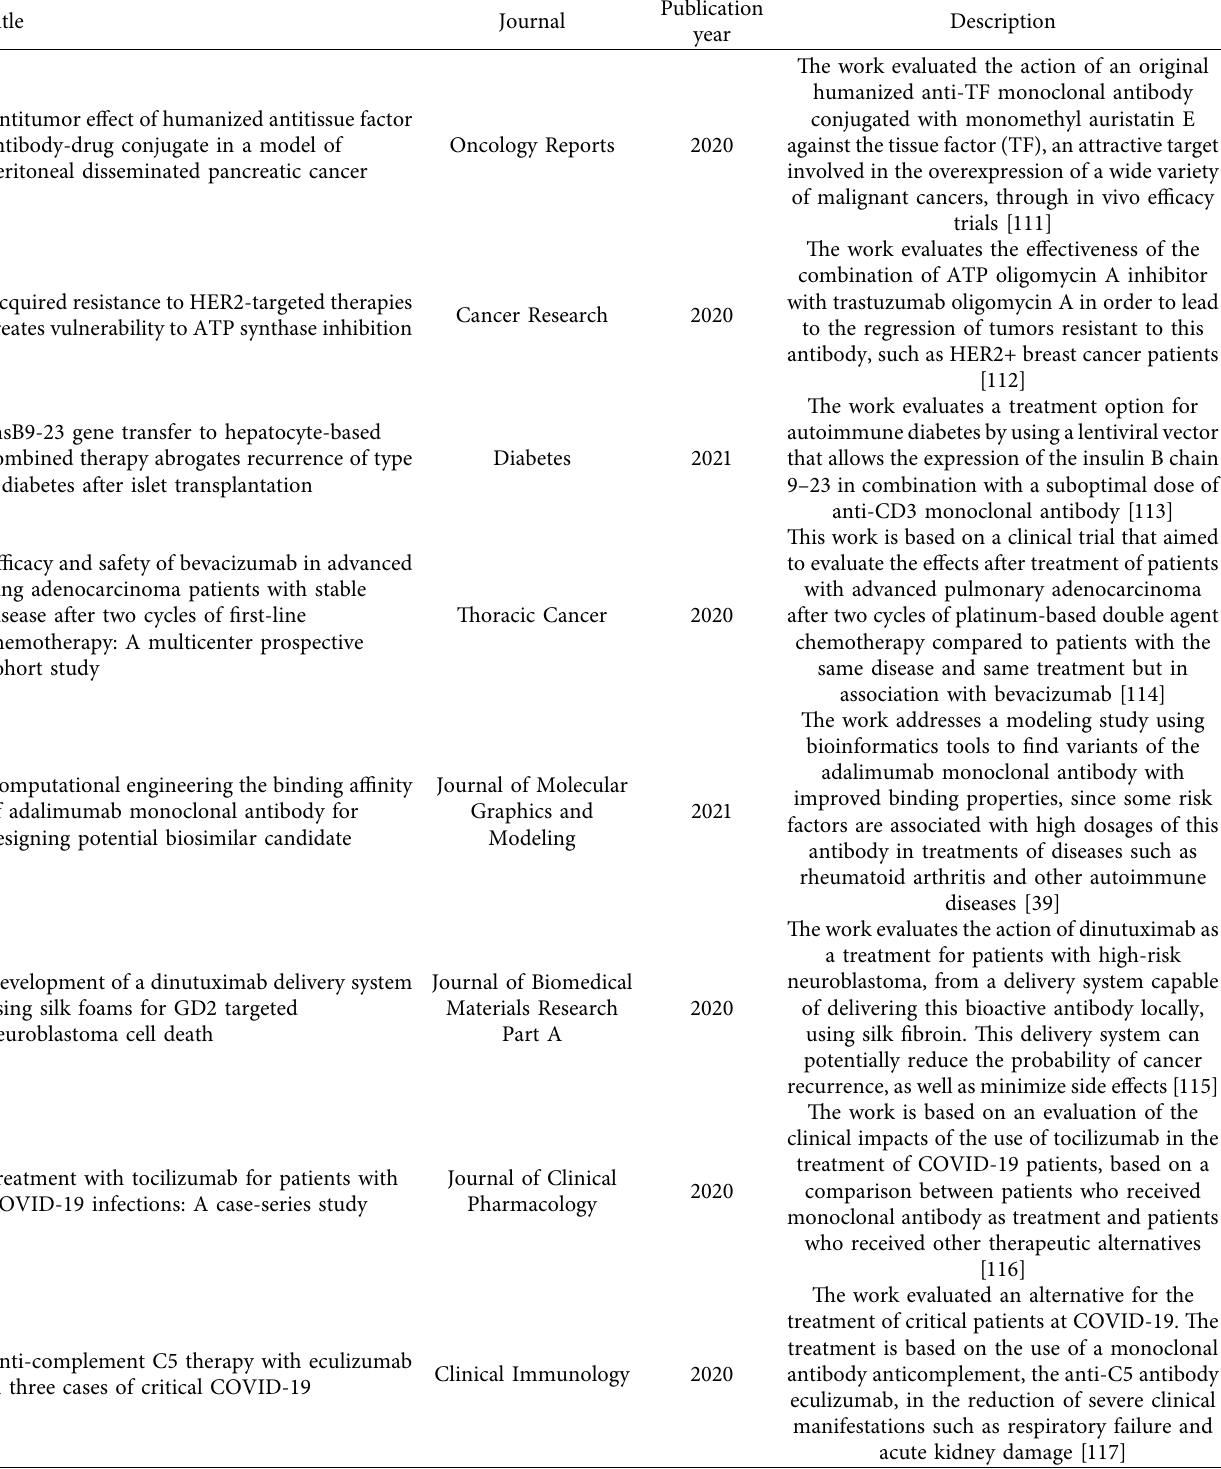
Table 3: Description of some recent studies on mAbs prospected in WoS